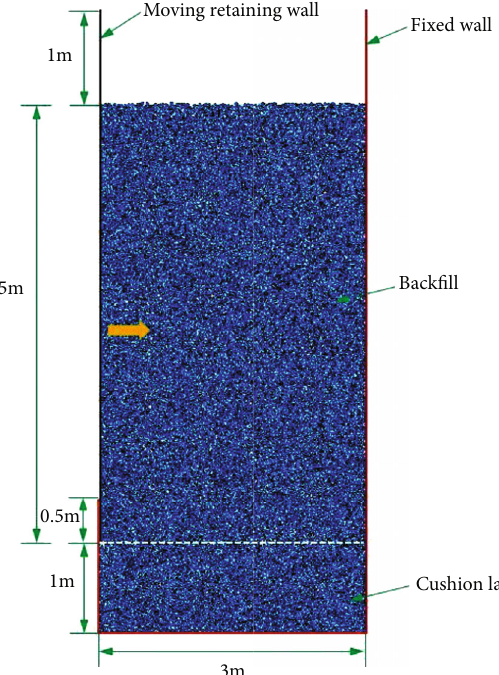
Figure 7: PFC model for soil behind retaining